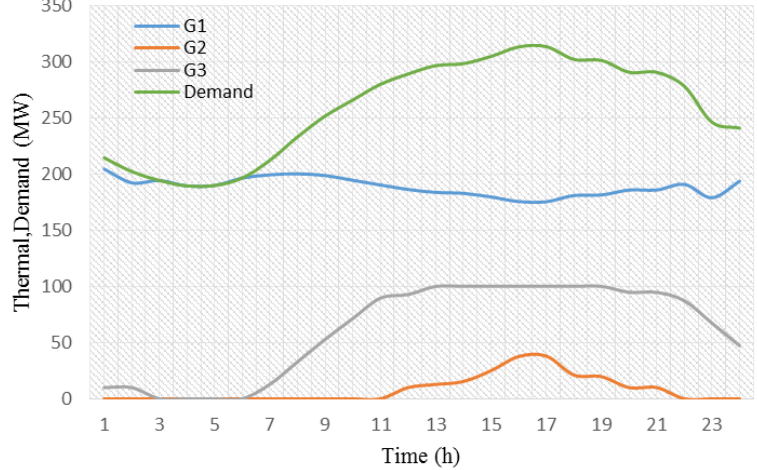
Figure 3. The production of thermal units and the predicted load curves in 24 h.